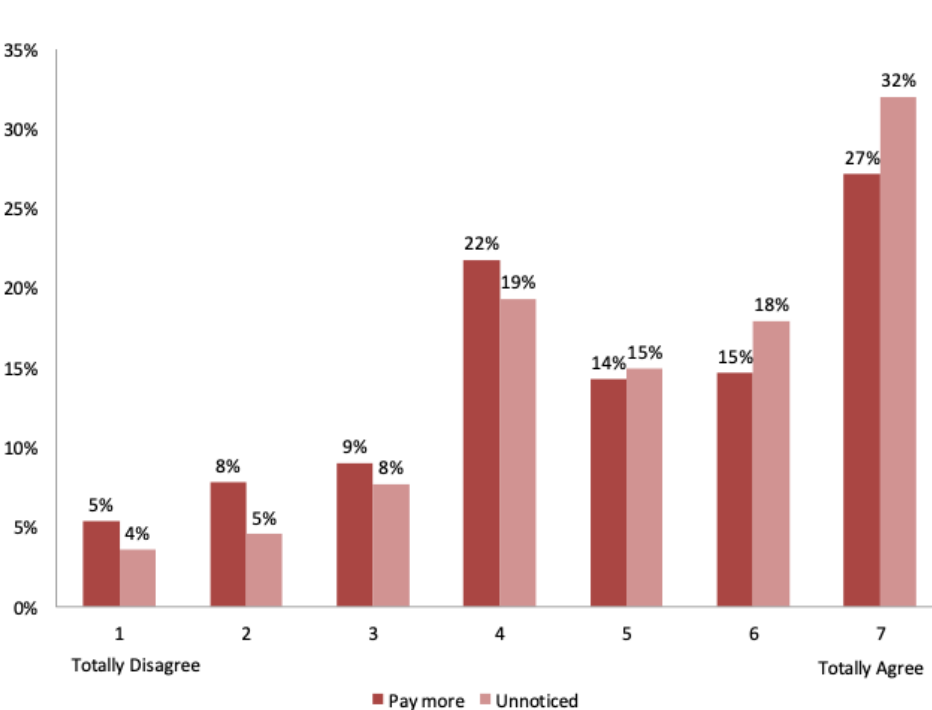
Figure 6: ’I worry that I may pay more for a product than others / price adjustments can be made without me noticing it’